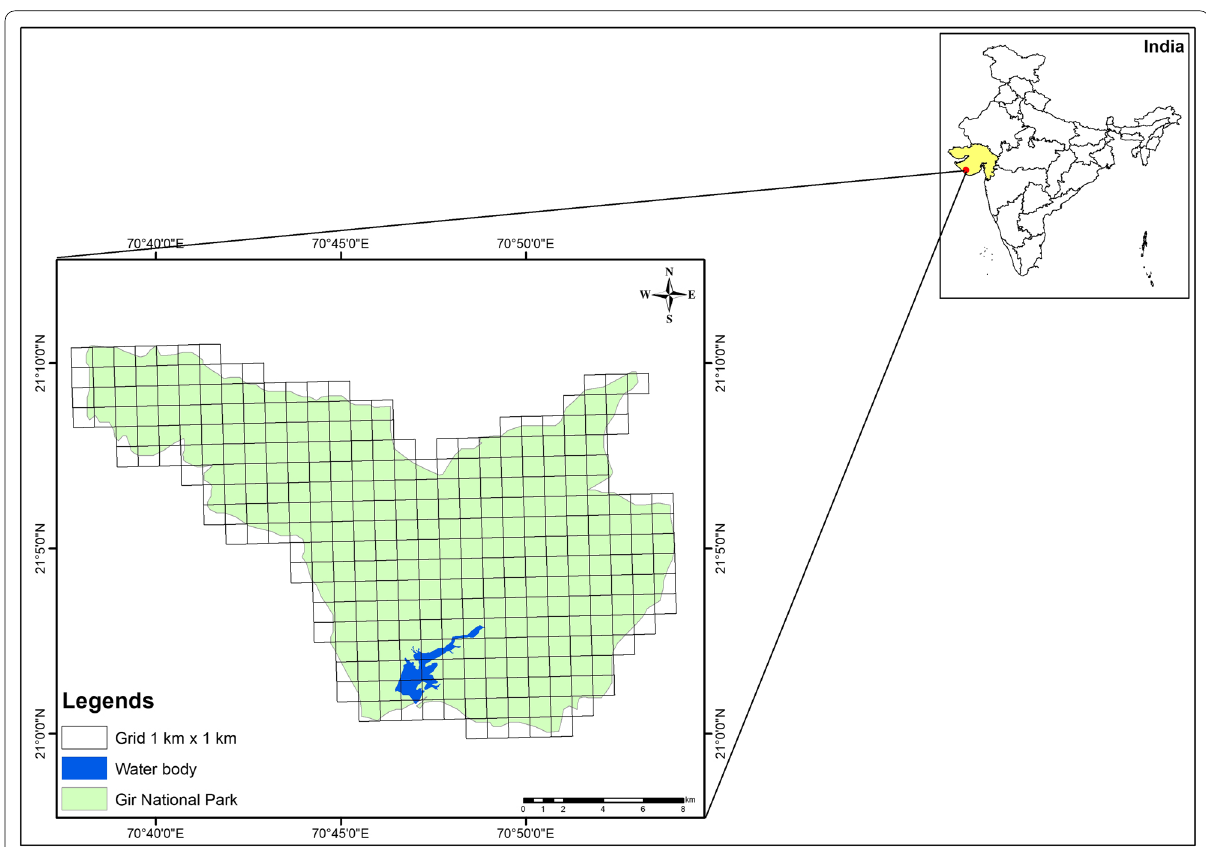
Fig. 1 Map of the study area indicating the grid